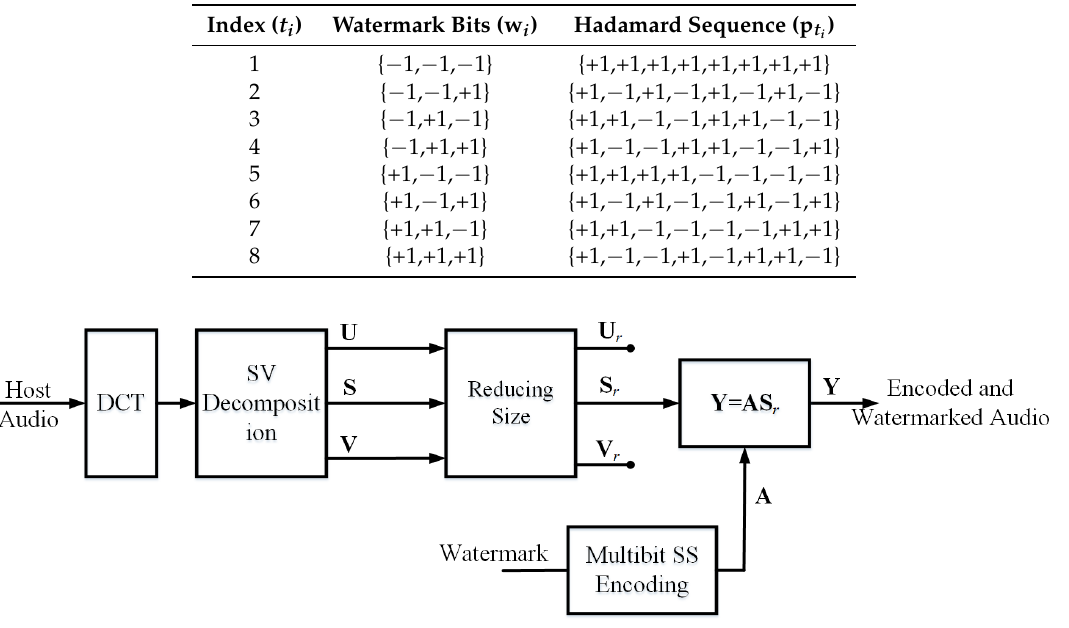
Figure 1. Watermark embedding and audio